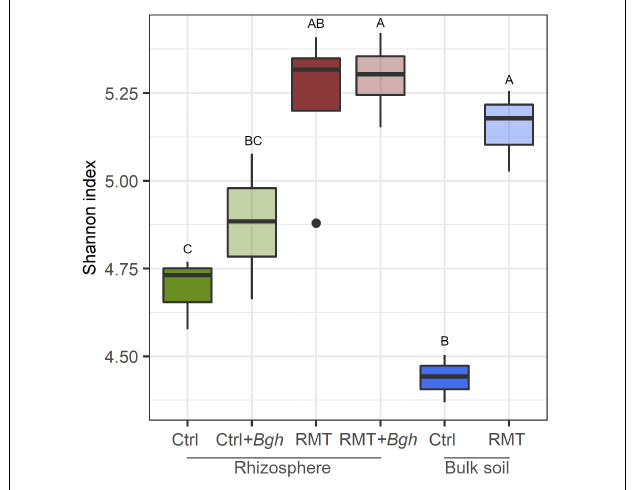
FIGURE 4 | Microbial alpha-diversity is higher after rhizosphere microbiome transplantation. Shannon index of rhizosphere microbiome transplant (RMT) or control (Ctrl) of barley rhizosphere and bulk soil samples. Barley was additionally infected with Bgh . Different letters indicate significant differences (Tukey’s test p ≤ 0.05) that were determined for rhizosphere and bulk soil samples independently. Means ± SD value are written in Supplementary Table 1